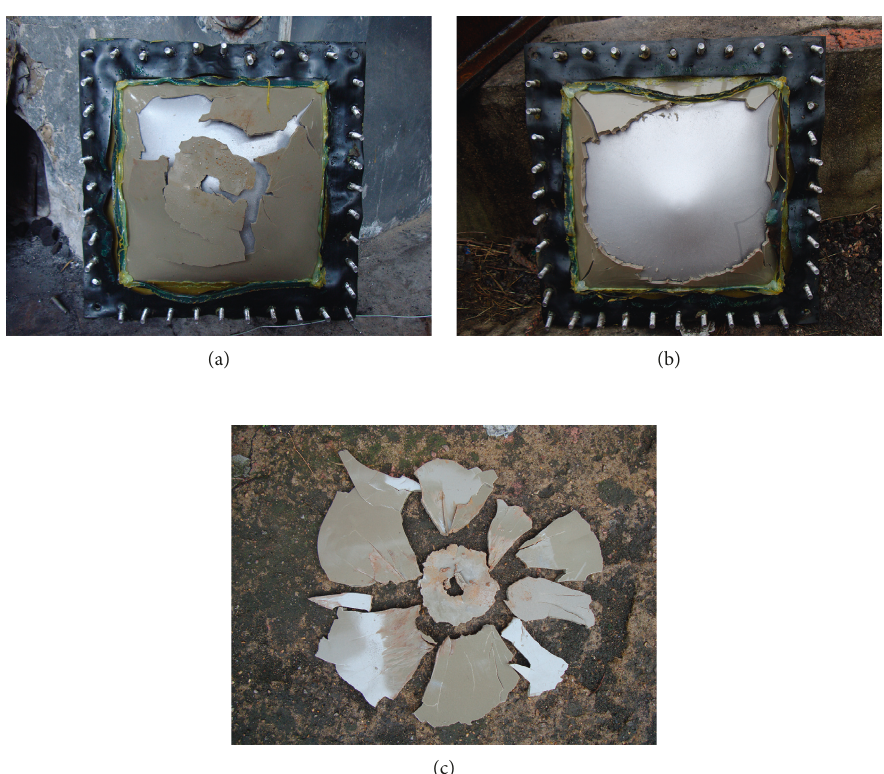
Figure 7: After the test, pictures of the back faces of steel plates with polyurea sprayed on the back surface: (a) 2mm polyurea coating; (b) 4 mm polyurea coating; (c) fragments of 4mm